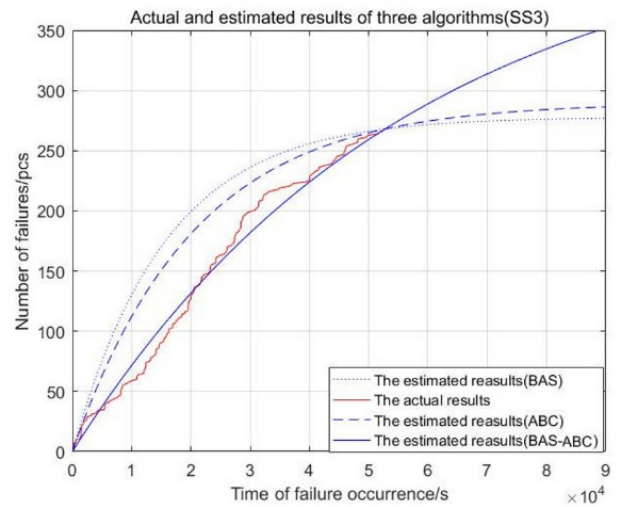
Figure 4. Actual and estimated time of failure occurrence of three algorithms (SS3).